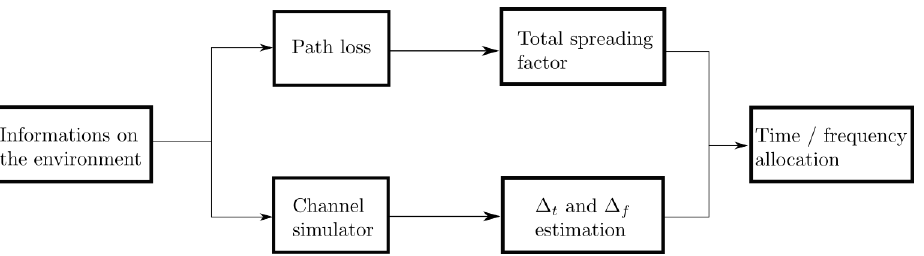
Figure 10. General process for allocating the spreading sequence in the time and frequency